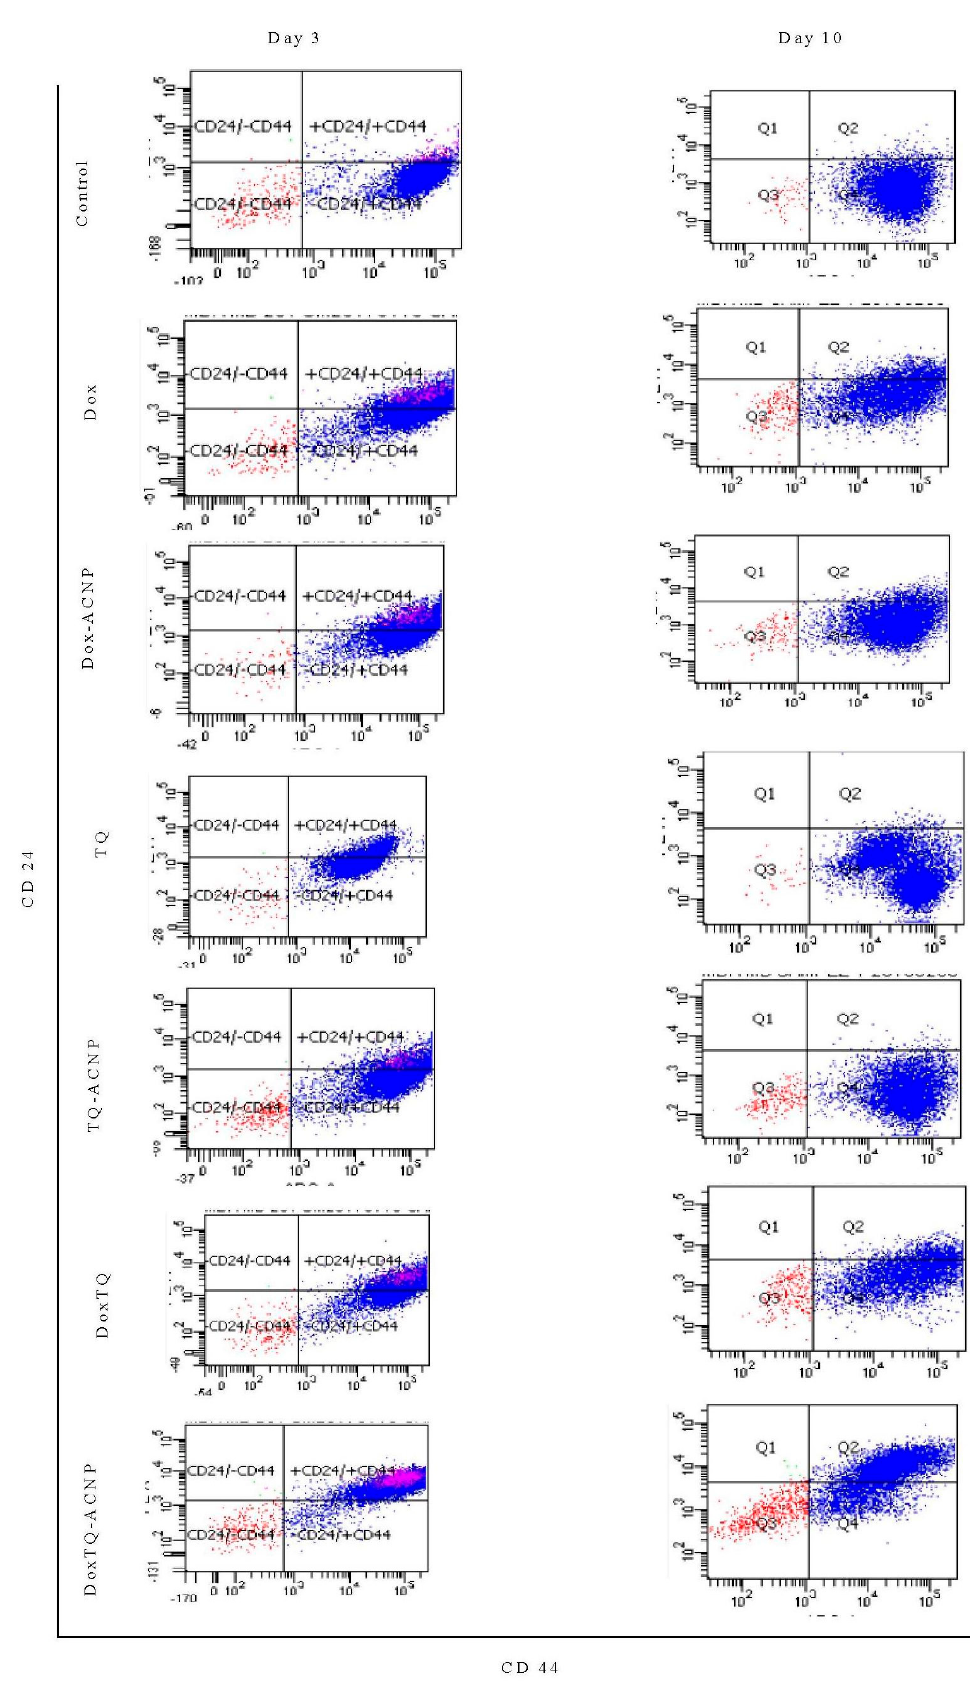
Figure 13. Flow cytometry representation of CD44+CD24- cells after treatment at days 3 and 10.